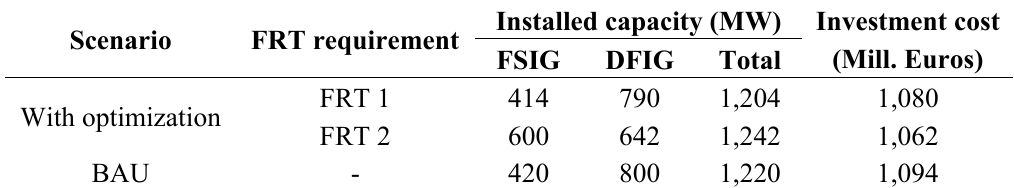
Table 3. Summary of obtained